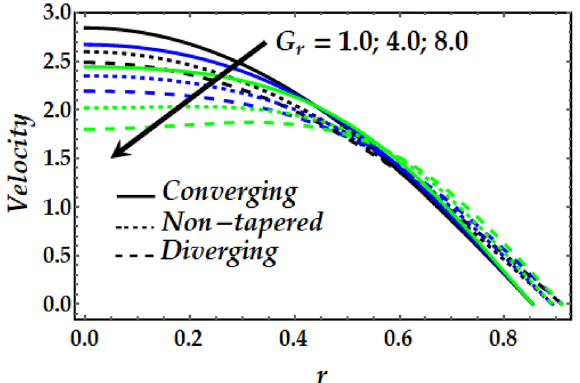
Figure 2. Velocity profile against distinct values of G r .